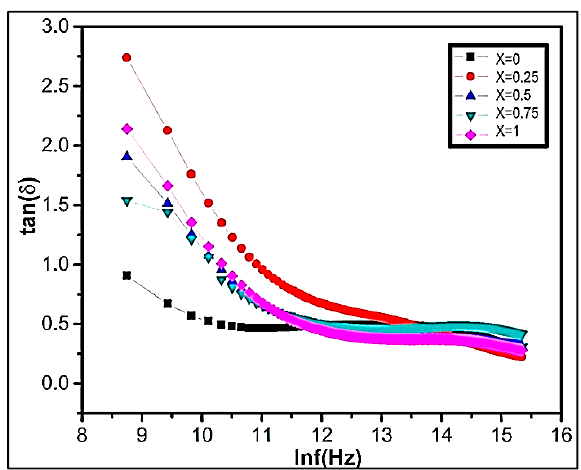
Figure 7. The variation of dielectric loss tangent tan( δ ) as a function of lnf(Hz) of Ni 1-x Zn x Fe 2 O 4 .